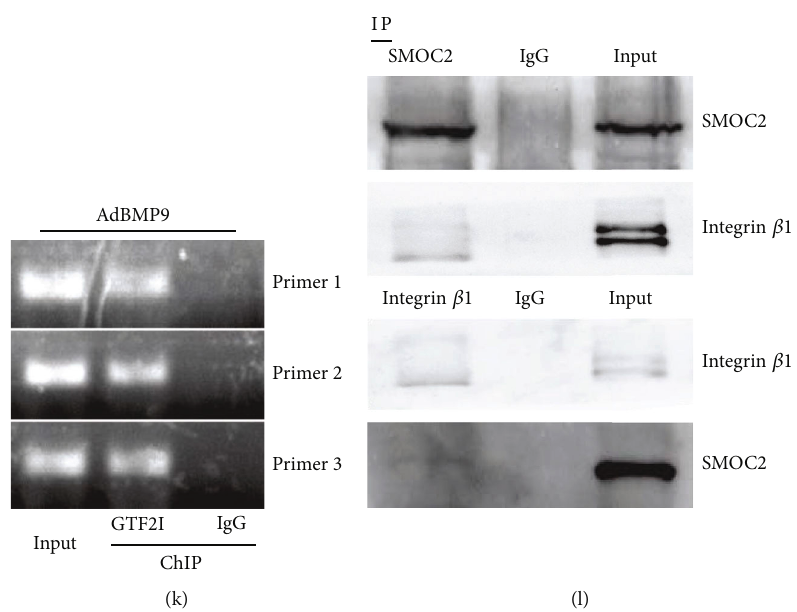
Figure 6: The activation of FAK/AKT signaling may be triggered by facilitating the interaction of SMOC2 and integrin β 1 in MEFs. (a) Western blot assay results showed the e ff ect of SMOC2 and/or siFAK on the phosphorylation levels of FAK and AKT promoted by BMP9 in MEFs at 30h. (b – c) Quanti fi cation of the western blot results showed the e ff ect of SMOC2 and/or siFAK on the phosphorylation levels of FAK and AKT promoted by BMP9 in MEFs. (d) ALP assay results showed the e ff ect of LY290042 on the activity of ALP induced by BMP9 in MEFs. (e) ALP assay results showed the e ff ect of SMOC2 and/or LY290042 on BMP9-induced ALP activity in MEFs. (f) Quanti fi cation results of the ALP assay showed the e ff ect of LY290042 on the activity of ALP induced by BMP9 in MEFs. (g) Quanti fi cation results of the ALP assay showed the e ff ect of SMOC2 and/or LY290042 on BMP9-induced ALP activity in MEFs. (h) Alizarin Red S staining showed the e ff ect of SMOC2 and/or LY290042 on BMP9-induced mineralization in MEFs. (i) Quanti fi cation results of Alizarin Red S staining showed the e ff ect of SMOC2 and/or Ly294002 on the e ff ect of BMP9-induced mineralization in MEFs. (j) Confocal laser scanning immuno fl uorescence staining results showed the e ff ect of SMOC2 on the phosphorylation of AKT induced by BMP9 in MEFs at 30h. (k) ChIP assay shows the enrichment of GTF2I at the promoter region of s moc2 in MEFs. (l) Immunoprecipitation assay (IP) results showed that SMOC2 may interact with integrin β 1 in MEFs. Compared with the control group, ∗ p < 0 : 05 ; ∗∗ p < 0 : 01 ; compared with the AdBMP9 group, # p < 0 : 05 , ## p < 0 : 01 ; compared with the AdBMP9 and LY290042 group, ^ p < 0 : 05 , ^^ p < 0 : 01